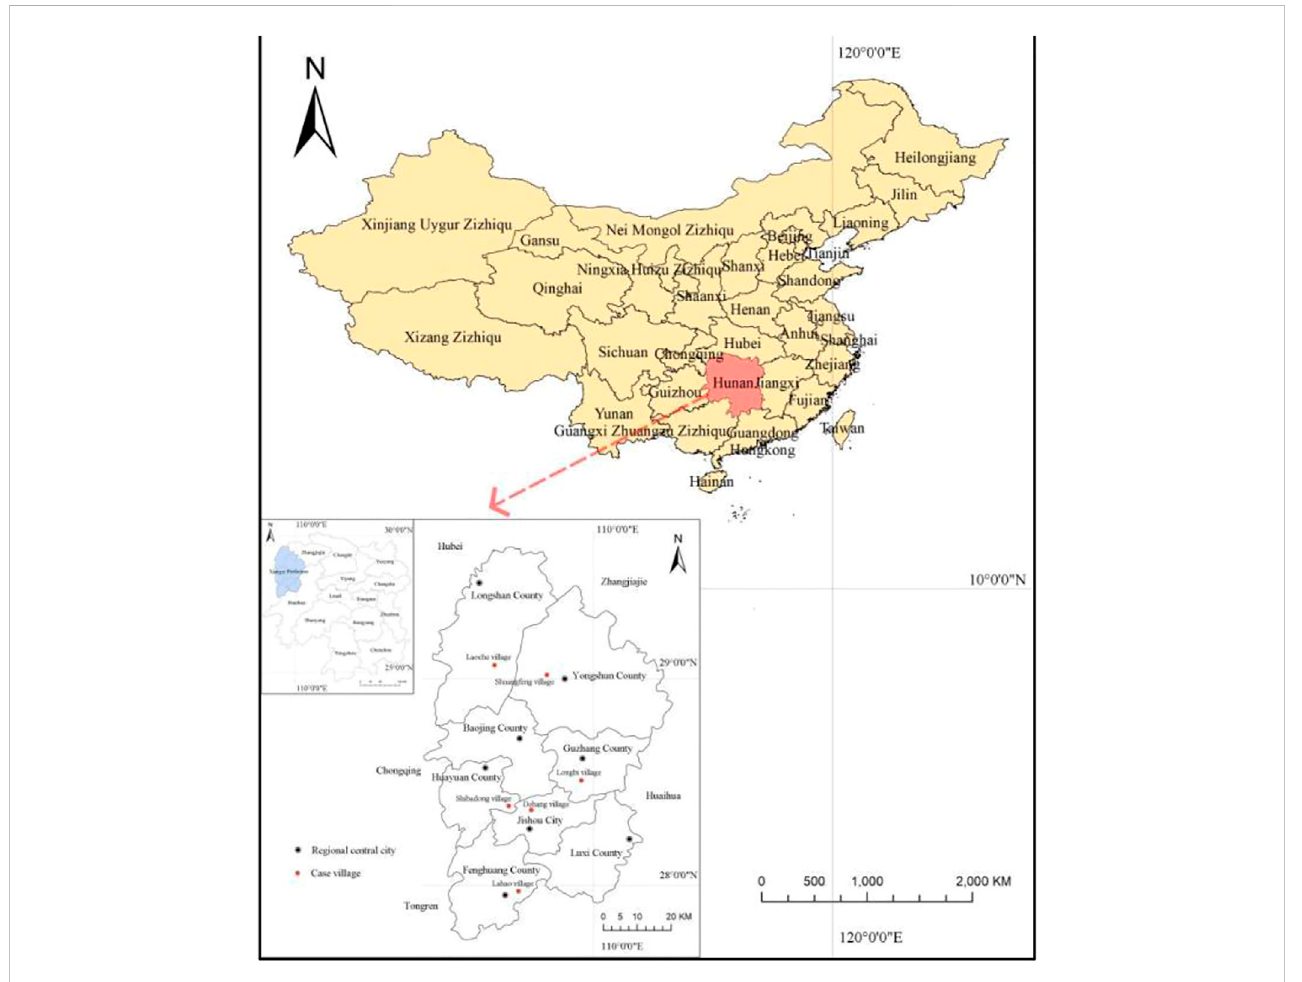
Location map of six